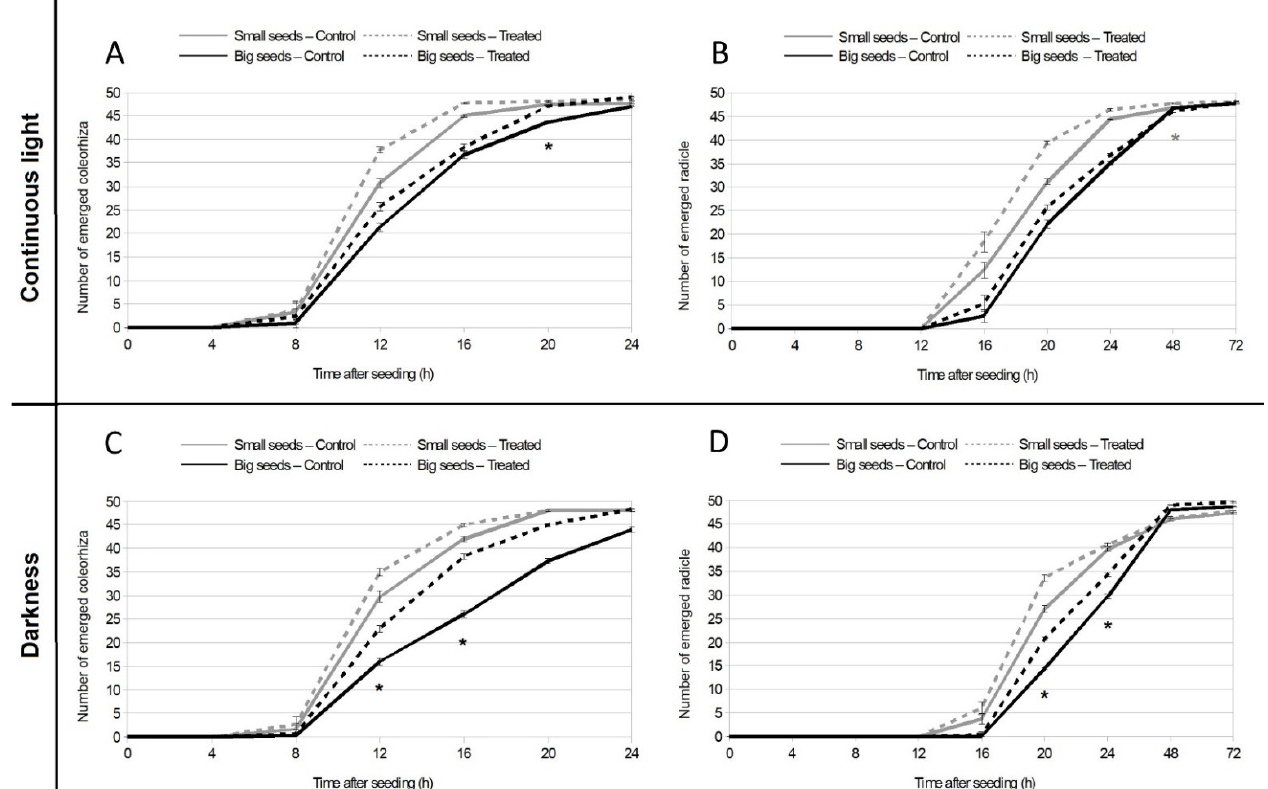
Figure 4. The germination kinetics, in continuous light and darkness, of coleorhiza emergence ( A , C ) and radicle emergence (complete germination) ( B , D ) of small and big seeds, in control conditions and after EMF treatment. Data are shown as mean values ( n = 3), and bars represent standard error ± SE. Gray and black asterisks (*) indicate significant differences (two-tailed t -test) between controls and EMF treatment at p < 0.05 for small and big seeds, respectively. Fifty seeds were the total sample size (100%) for each repetition. Table 1. Effect of seed size of winter wheat and light conditions (continuous light and darkness) on the kinetics (expressed as time in hours) of coleorhiza emergence during germination of control samples (without EMF